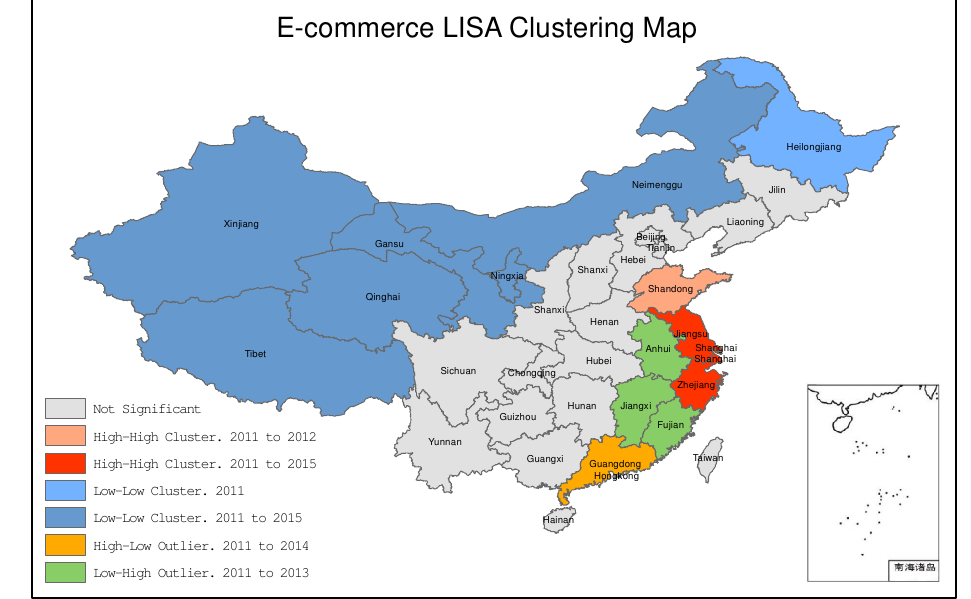
Figure 1. LISA clustering analysis of e-commerce by using local Moran’s model